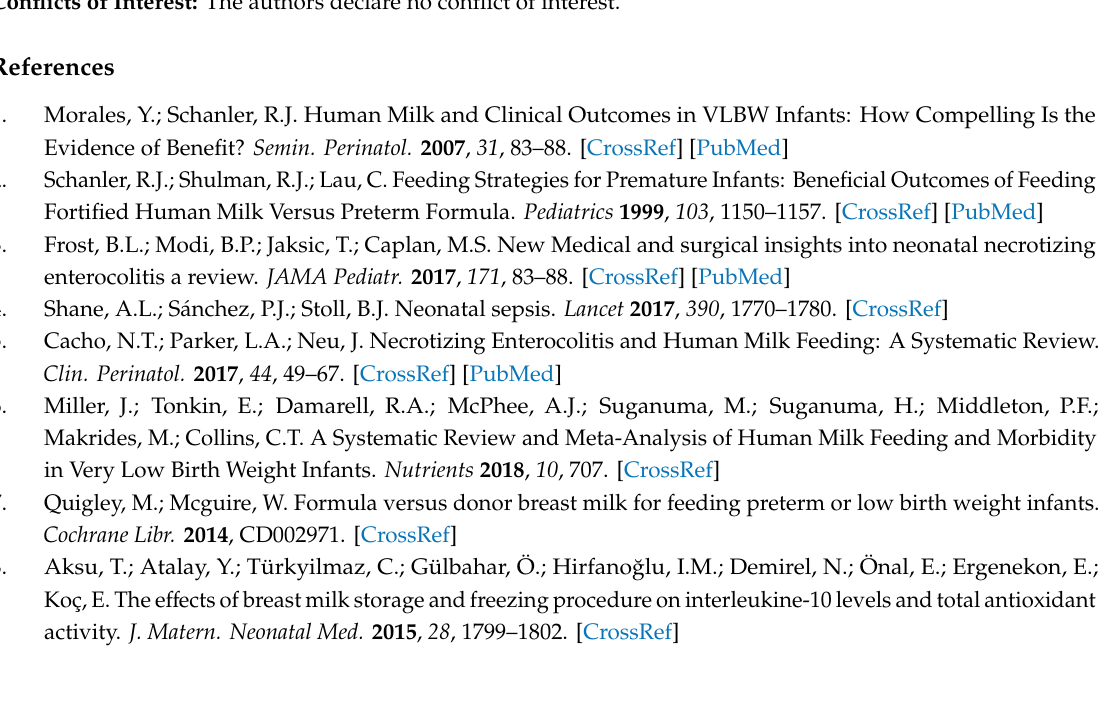
Table S1: Multivariate analysis by linear regression of the determinants of fall in weight z-score at 28 day of life, Table S2: Multivariate analysis by logistic regression of the determinants of